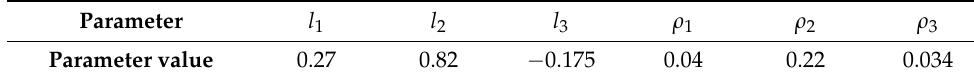
Table 2. Feedback gain table of the Sliding Mode Observer.